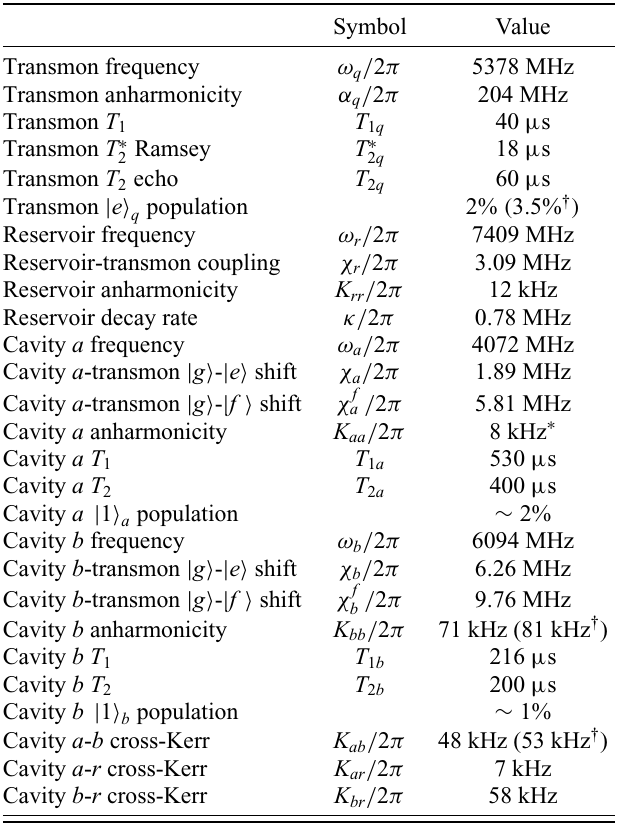
TABLE II. The measured system